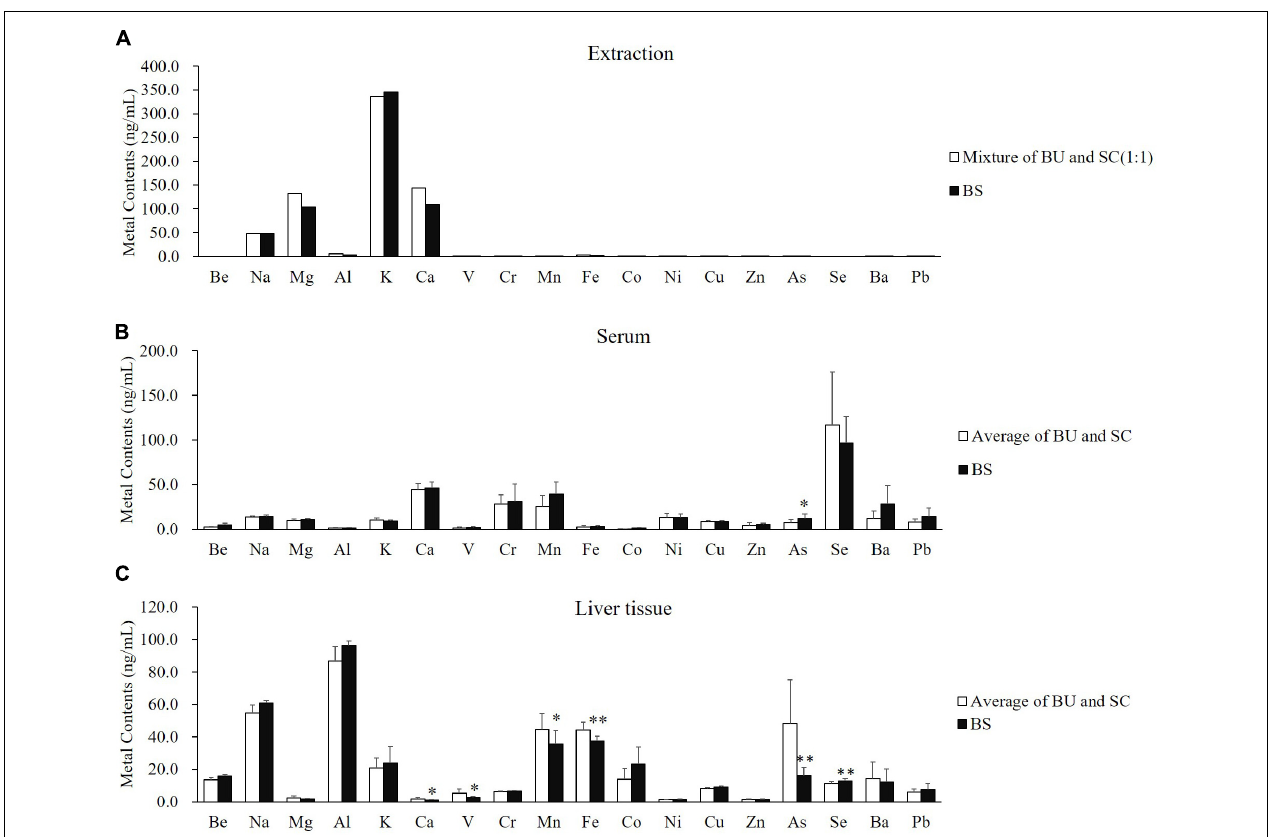
FIGURE 3 | B. chinense - S. baicalensis herbal pair altered the distribution of metal contents in the serum and liver tissue. (A) Comparison of metal contents between average of BU and SC (white column) and BS (black column). (B) Comparison of serum metal contents between average of BU-treated and SC-treated rats (white column) and BS-treated rats (black column). (C) Comparison of hepatic metal contents between average of BU-treated and SC-treated rats (white column) and BS-treated rats (black column). BU: decoctions of B. chinense ; SC: decoctions of S. baicalensis ; BS: decoctions of Bupleurum chinense - S. baicalensis .